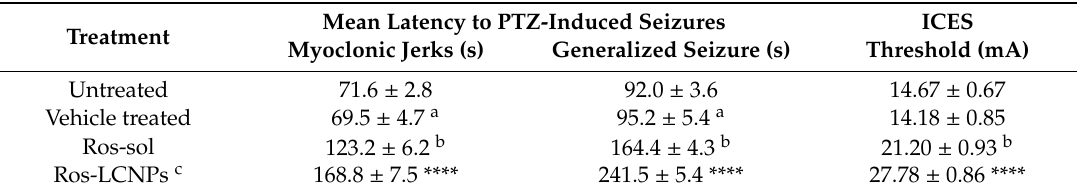
Table 2. E ff ect of Ros-LCNPs on PTZ-induced seizures and ICES; Data are expressed as mean ± SEM; n = 6 in each group, ANOVA followed by Tukey’s test.